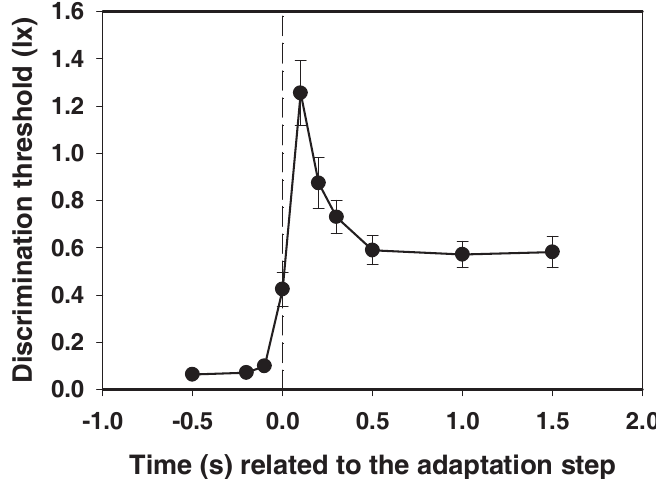
Figure 2. Time course of the discrimination threshold, averaged for all nine test subjects, with standard deviations. Basic adaptation light 0.5 lx, adaptation light step 2.5